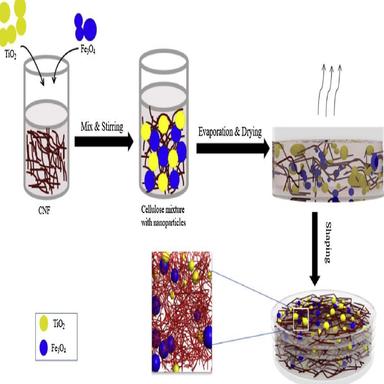
Schematic representation of the process of obtaining CNF composite nanopaper.